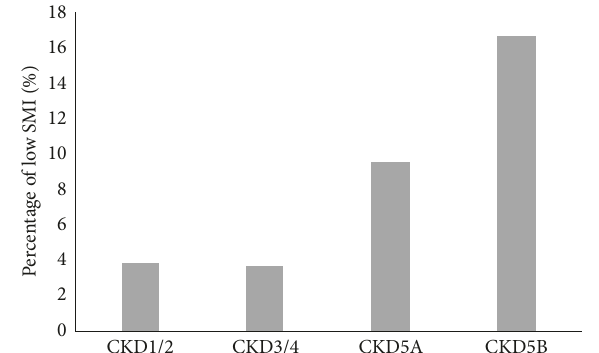
Table 3: Correlation between ln PTH and nutritional indicators.